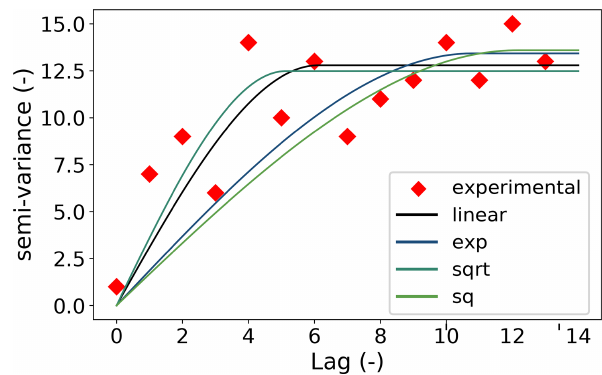
Figure 9. Red diamonds show a sample experimental variogram (values are made up) with four different spherical variogram mod- els. All four models are fitted using the trust-region reflective fitting procedure and distance-dependent weights. The weights are linear decreasing with distance (blue line), decreasing by the square root of the normalized distance (green line), the squared normalized dis- tance (red line) and decreasing by exponential function as shown in Eq. (22) (yellow line).